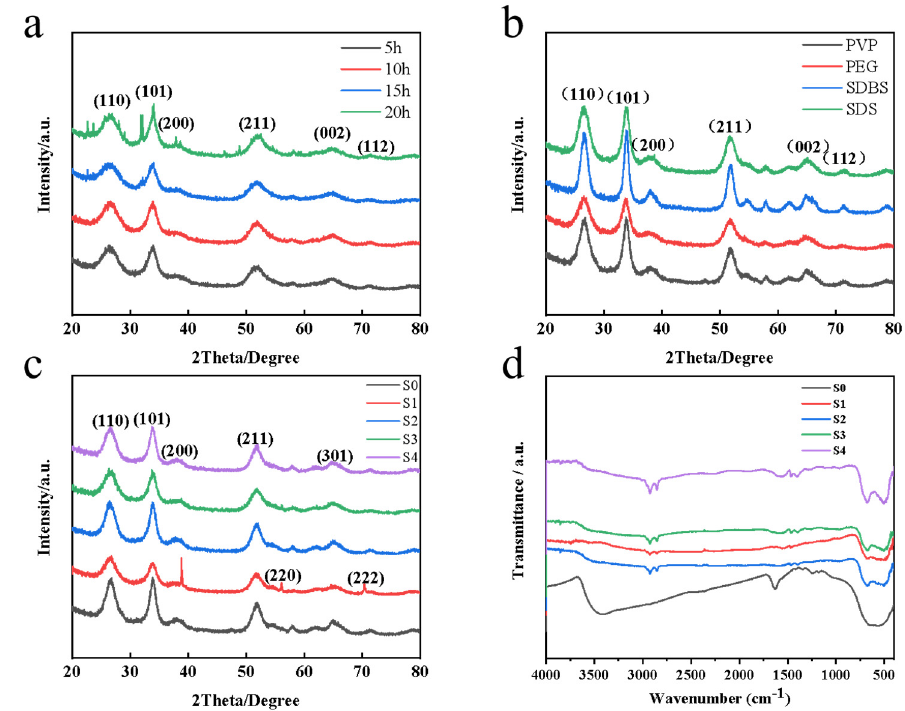
Figure 1. XRD patterns of ( a ) different reaction times, ( b ) different surfactants at 5 h of solvothermal and ( c ) different F ratios. ( d ) Fourier transform infrared spectrum of SnO 2 sample obtained from different fluorine doping ratios.